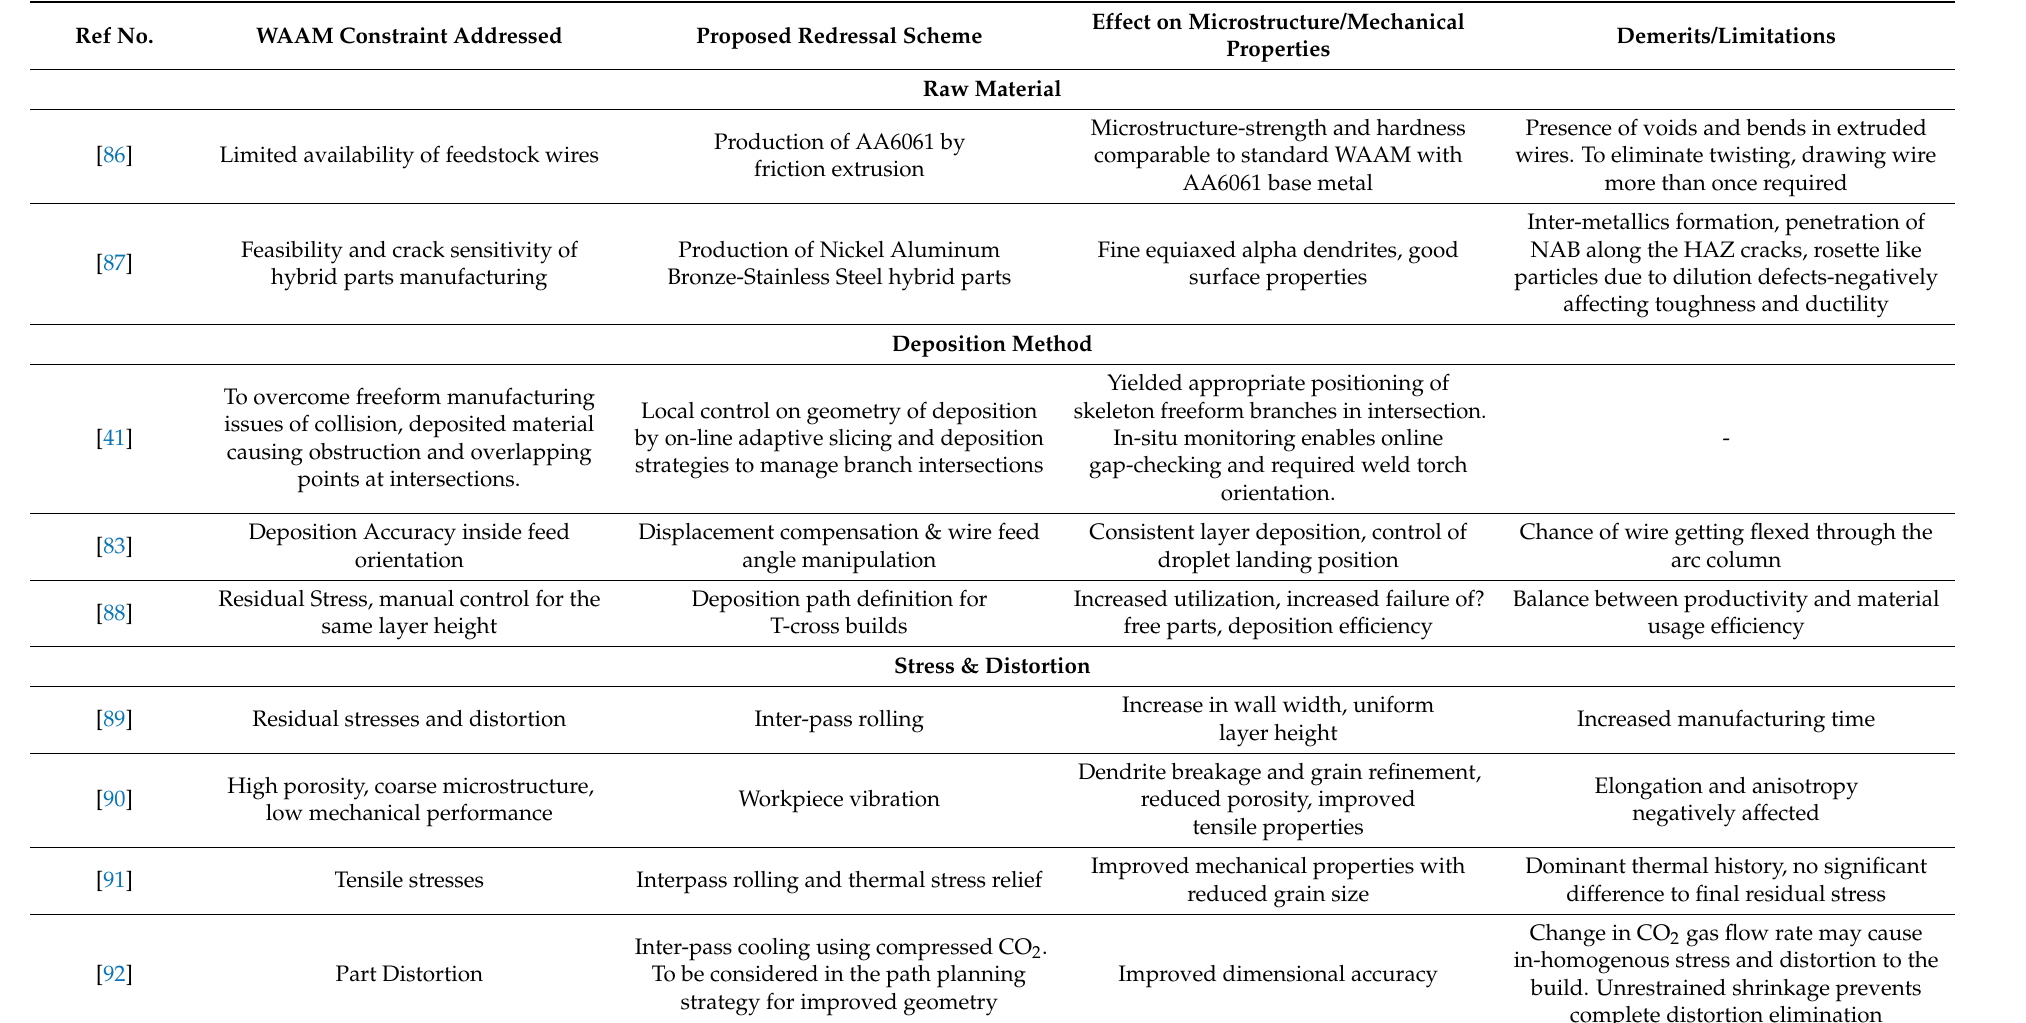
Table 1. Constraints and limitations in the WAAM